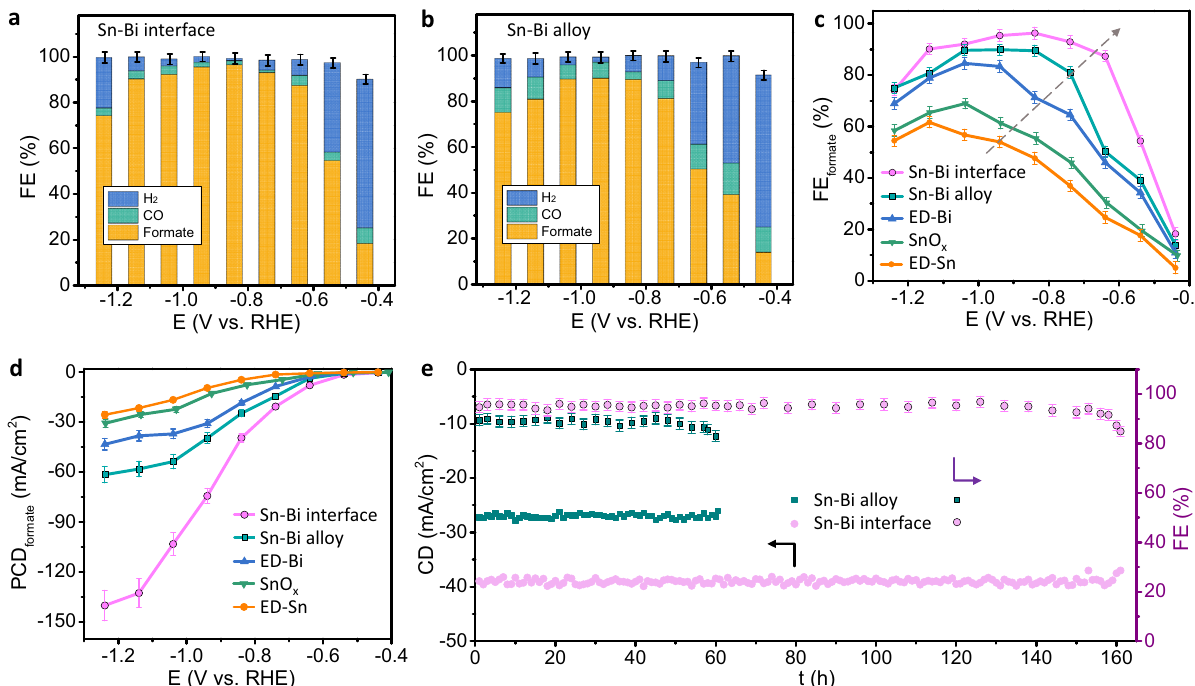
Fig. 5 CO 2 RR performance. a , b FE toward CO, formate and H 2 for Sn – Bi interface and Sn – Bi alloy. c FE of formate, d Partial current density toward formate for various samples: Sn – Bi interface, Sn – Bi alloy, ED-Bi from electrodeposition, SnO x from hydrothermal method, and ED-Sn from electrodeposition. e The stability testing of Sn – Bi interface and alloy at − 0.84 V vs. RHE.